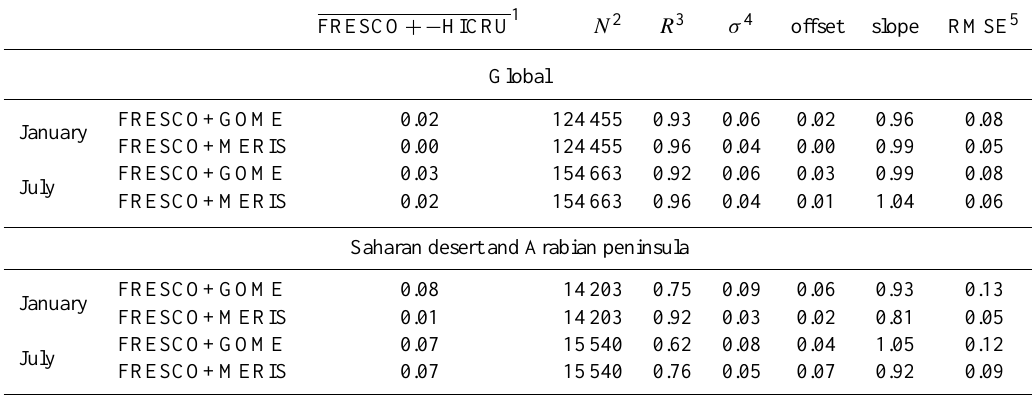
Table 2. Comparison between FRESCO+GOME/MERIS and HICRU cloud fraction over snow/ice-free land surfaces between 50 ◦ N and 50 ◦ S as well as over a subscene containing the Saharan desert and the Arabian peninsula [15 ◦ N–30 ◦ N and 15 ◦ W–60 ◦ E]. In FRESCO+, a cloud albedo of 0.9 is used and only cloud fractions < 0 . 8 are considered.